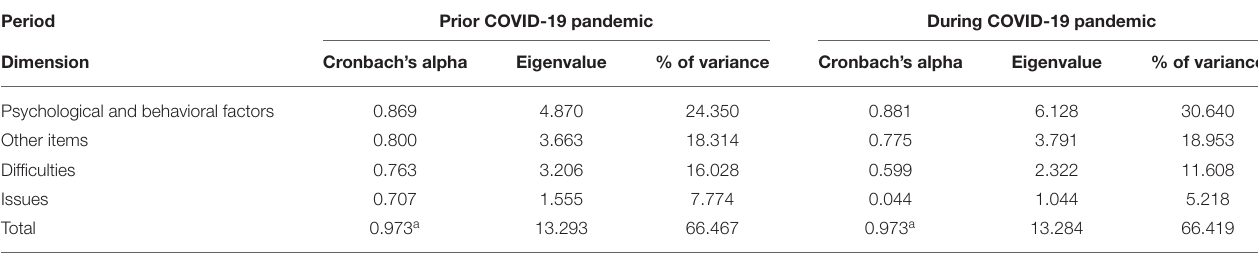
TABLE 7 | Statistics on variation reflected by factors extracted with CATPCA. Period Prior COVID-19 pandemic During COVID-19 pandemic Dimension Cronbach’s alpha Eigenvalue % of variance Psychological and behavioral